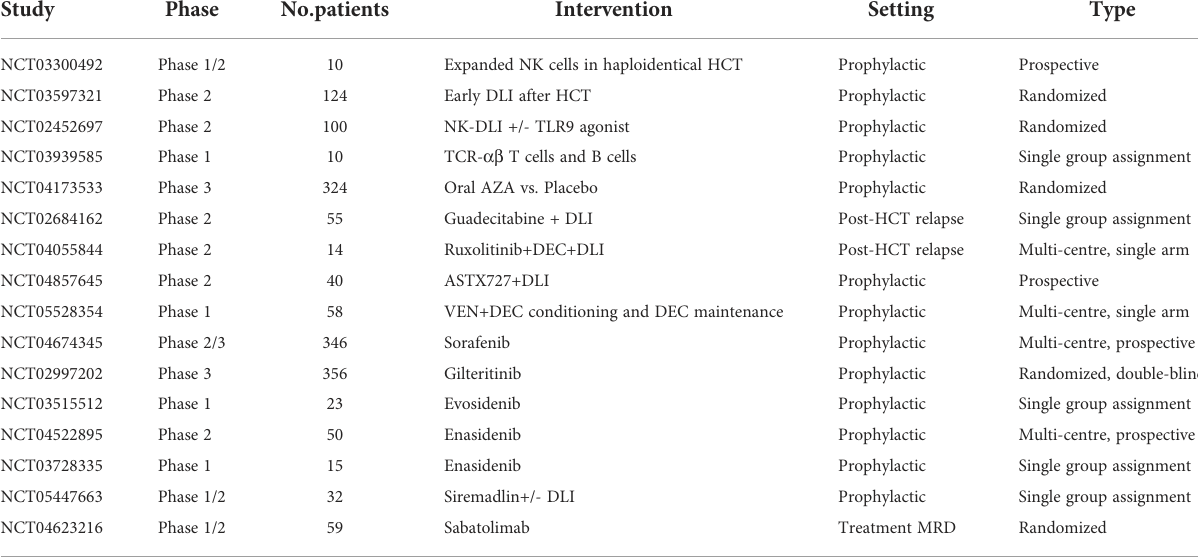
TABLE 3 Active Clinical trials in post-HCT relapse of